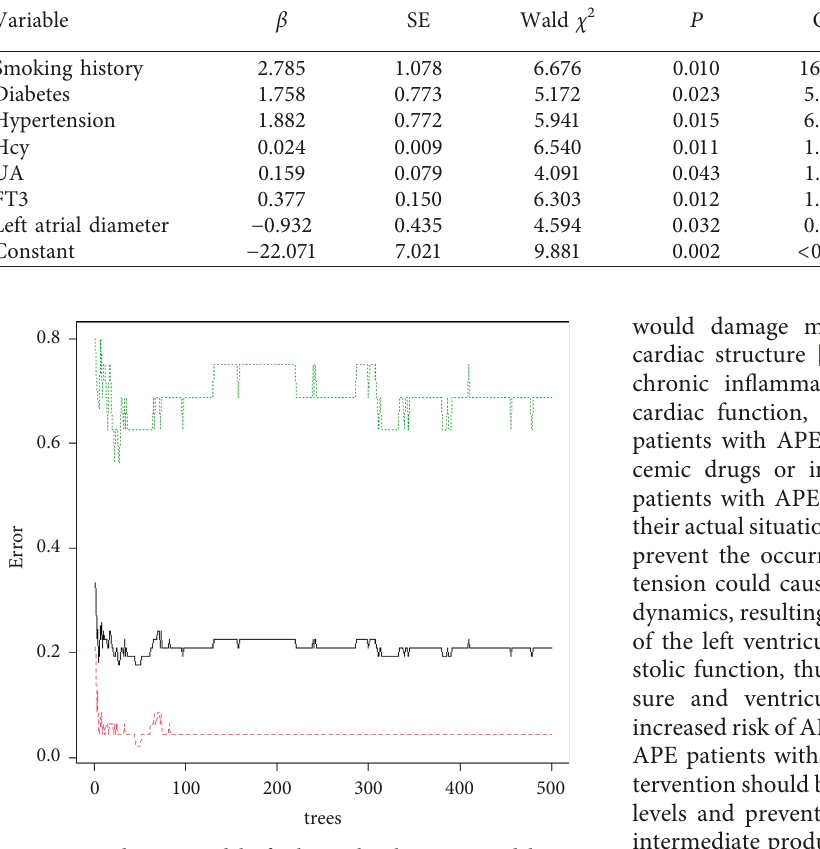
Figure 1: Prediction model of relationship between model error and number of random trees. Table 4: Mean decrease Gini of RF model variables.